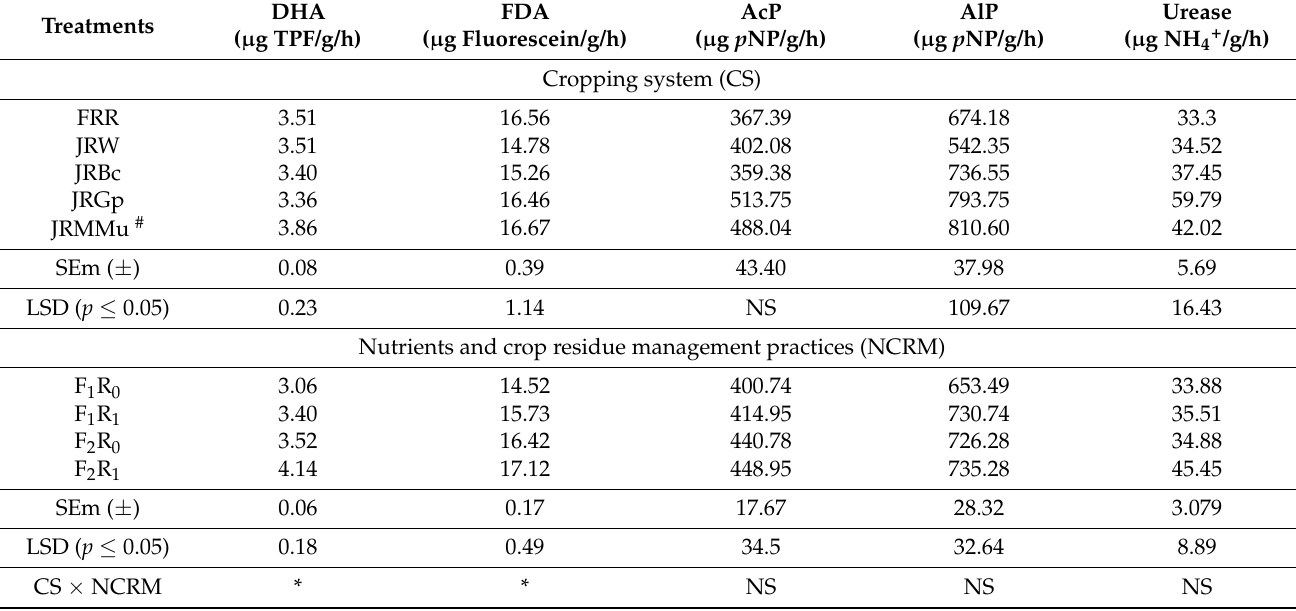
Table 4. Soil enzymes are influenced by different cropping systems and nutrient and crop residue management practices.